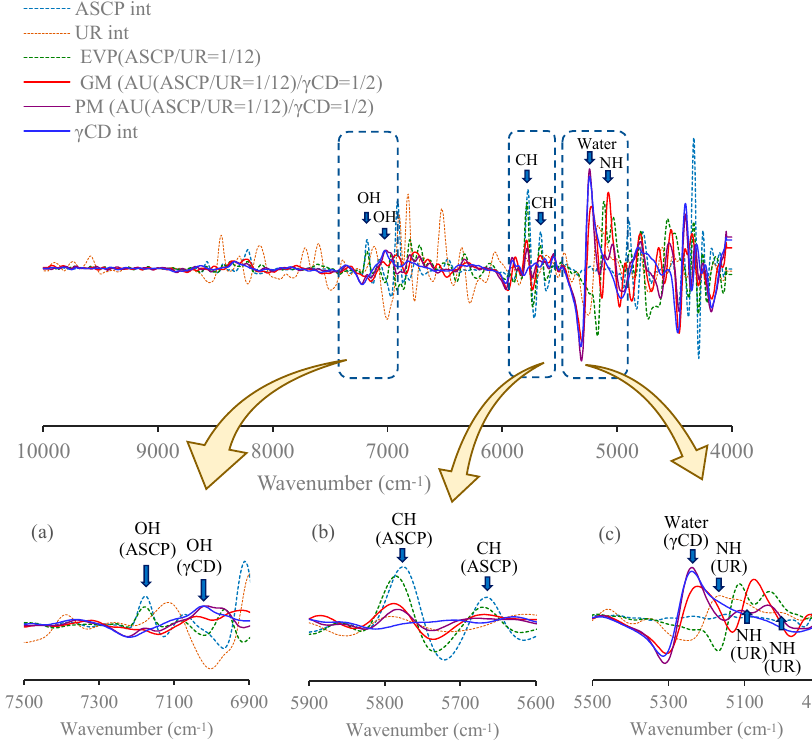
Figure 6. Second-derivative NIR absorption spectra for an AU (ASCP/UR = 1/12)/ γ CD system. ( a ) 7500–6900 cm − 1 , ( b ) 5900–5600 cm − 1 , ( c ) 5500–4900 cm − 1 .